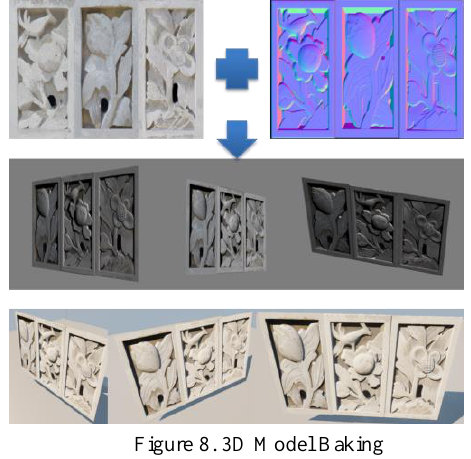
Figure 8. 3D Model Baking